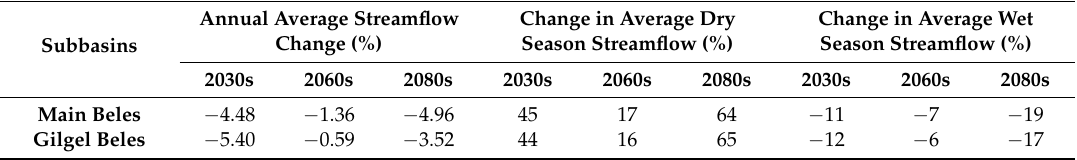
Table 3. Average annual streamflow and change in average seasonal stream flow between the three-time horizons from the baseline period.